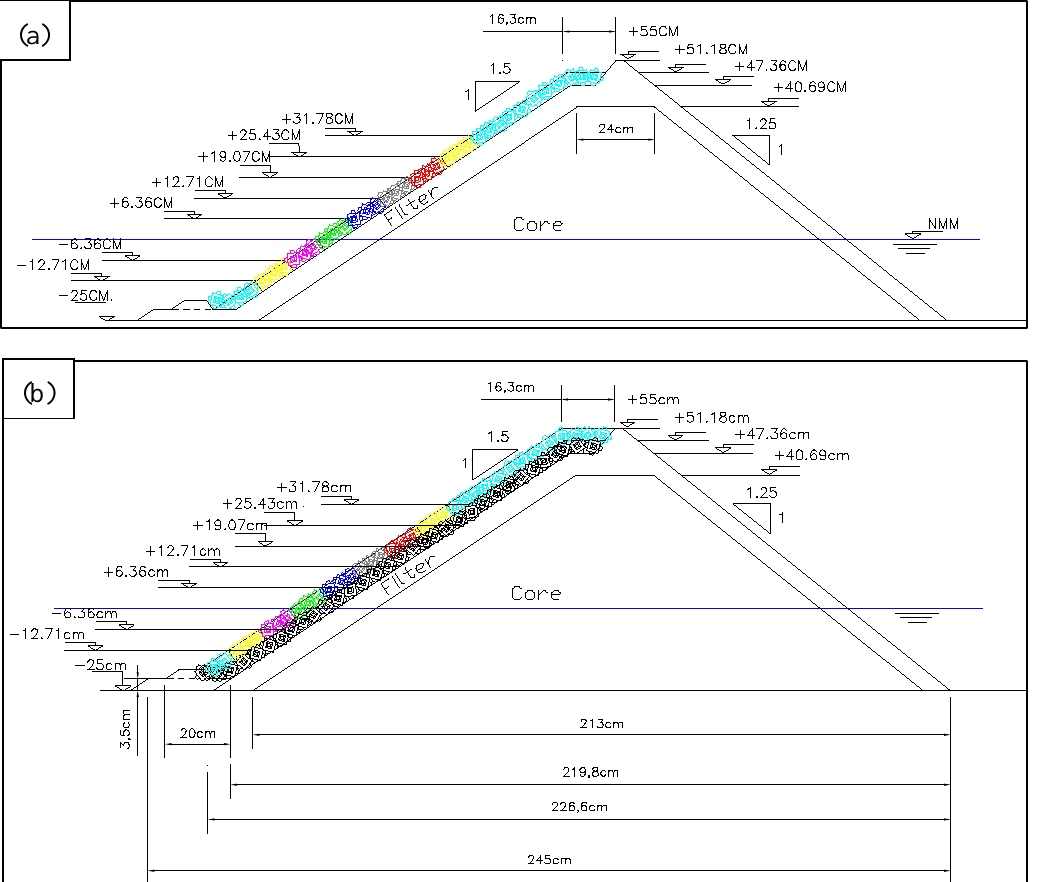
Figure 3. Cross-sections of ( a ) single- and ( b ) double-layer Cubipod ® models with the toe berm.